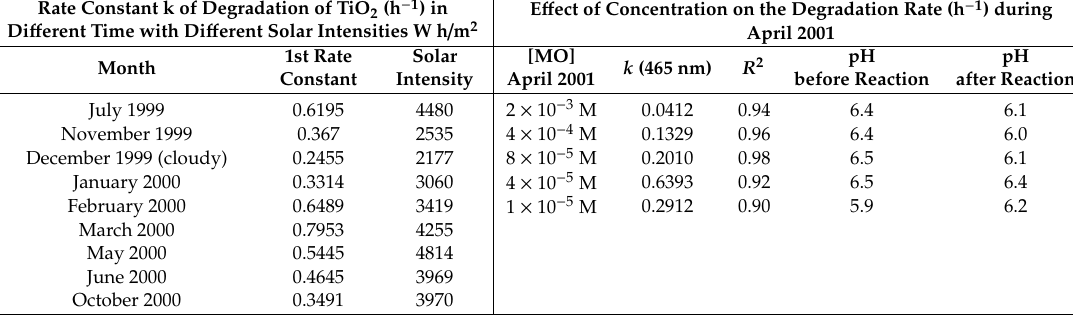
Table 1. Results on detoxification of methyl orange (MO) as under di ff erent conditions (MO concentration, pH, TiO 2 concentration and solar intensity). Reprinted from Ref. [254], Copyright (2002), with permission from